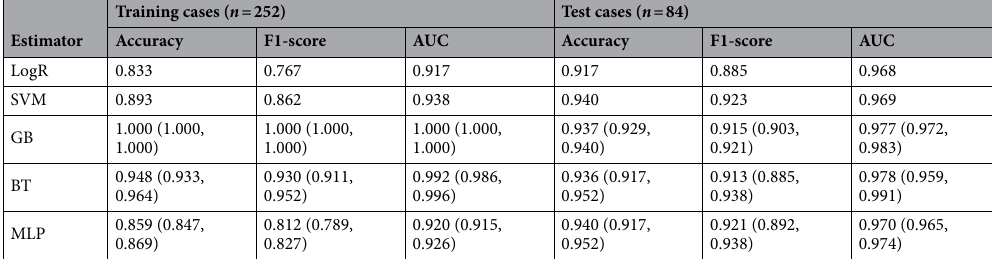
Table 1. Performance of train and test data of estimating severe fever with thrombocytopenia syndrome occurrence, using the classification model in machine learning. Numbers in parentheses indicate the 95% confidence interval obtained from 100